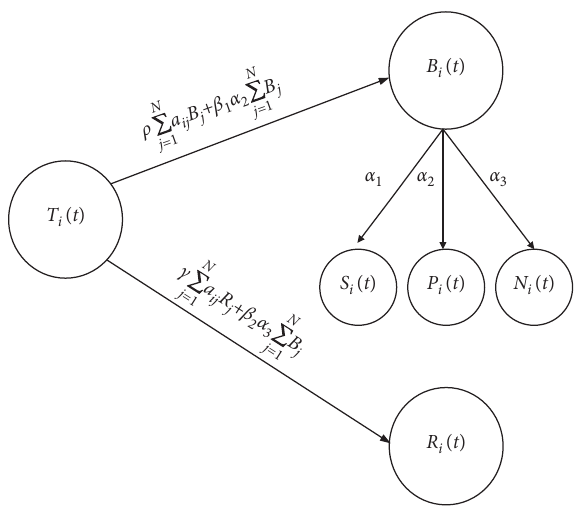
Figure 1: State transition diagram of individual V